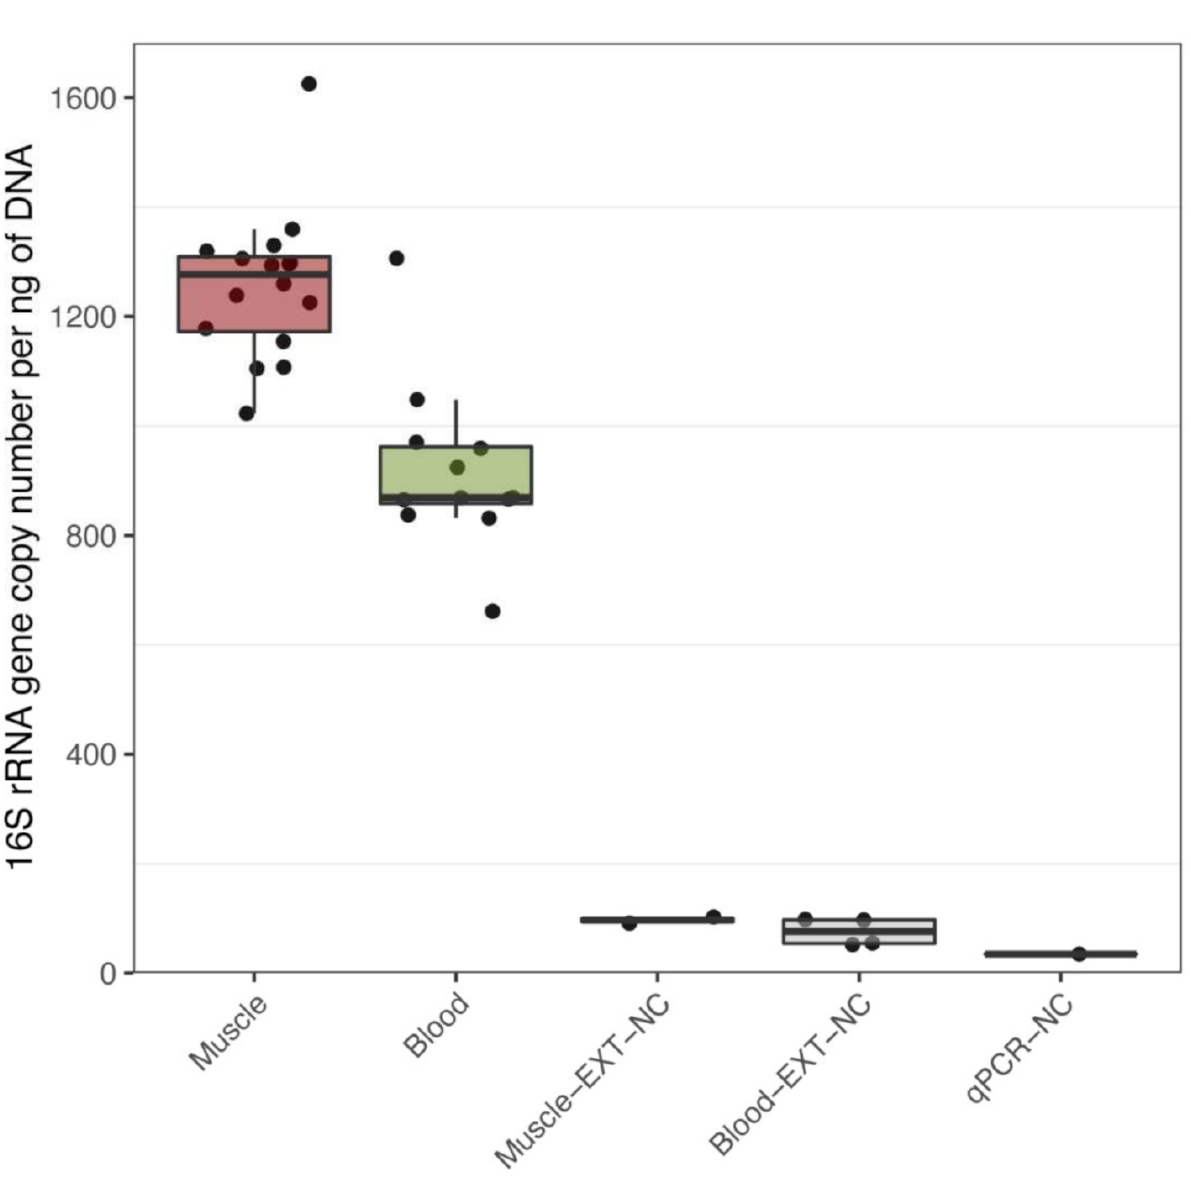
Figure 1. Quantitative PCR detection of bacterial DNA in muscle and blood. Quantification of 16s rRNA per ng of total DNA as measured by quantitative polymerase chain reaction (qPCR) in skeletal muscle biopsies (Muscle), blood (Blood), as well as in the following negative controls (NC) buffers used of DNA extraction for skeletal muscle (Muscle-EXT-NC), blood (Blood-EXT-NC) and water, buffers and reagents used for PCR (qPCR-NC). Analysed by Tukey’s multiple comparison test using 95% family-wise confidence